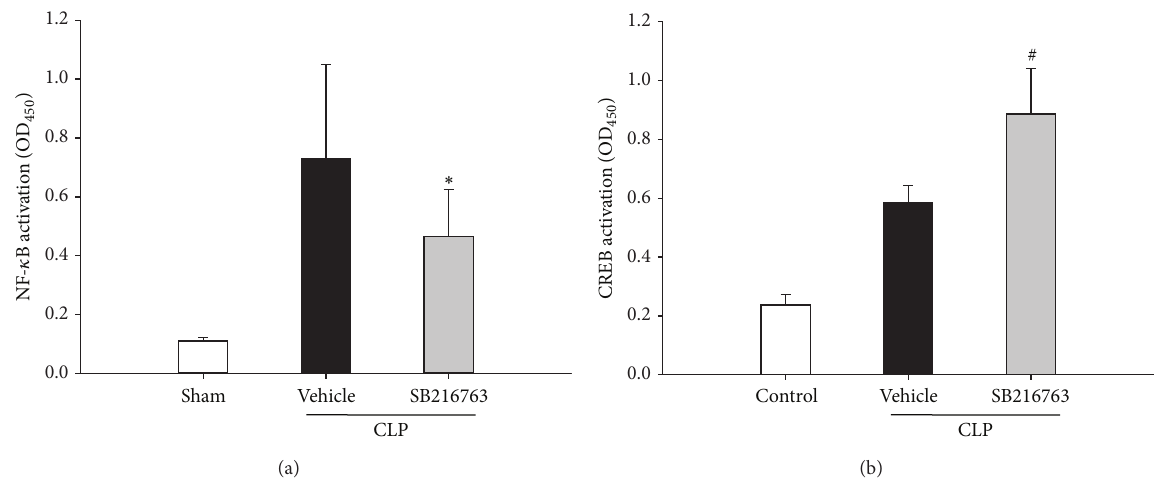
Figure 4: GSK-3 𝛽 inhibition modulates the NF- 𝜅 B and CREB activation following CLP. Mice were subjected to CLP and treated with either SB216763 (25mg/kg, i.p.) or vehicle (DMSO). Liver samples were harvested at 20 h after CLP. NF- 𝜅 B activity, as well as CREB activity, was assessed. Data are shown as mean ± SD. 𝑛 = 6 per group. ∗ 𝑃 < 0.05 , # 𝑃 < 0.01 compared with vehicle-treated